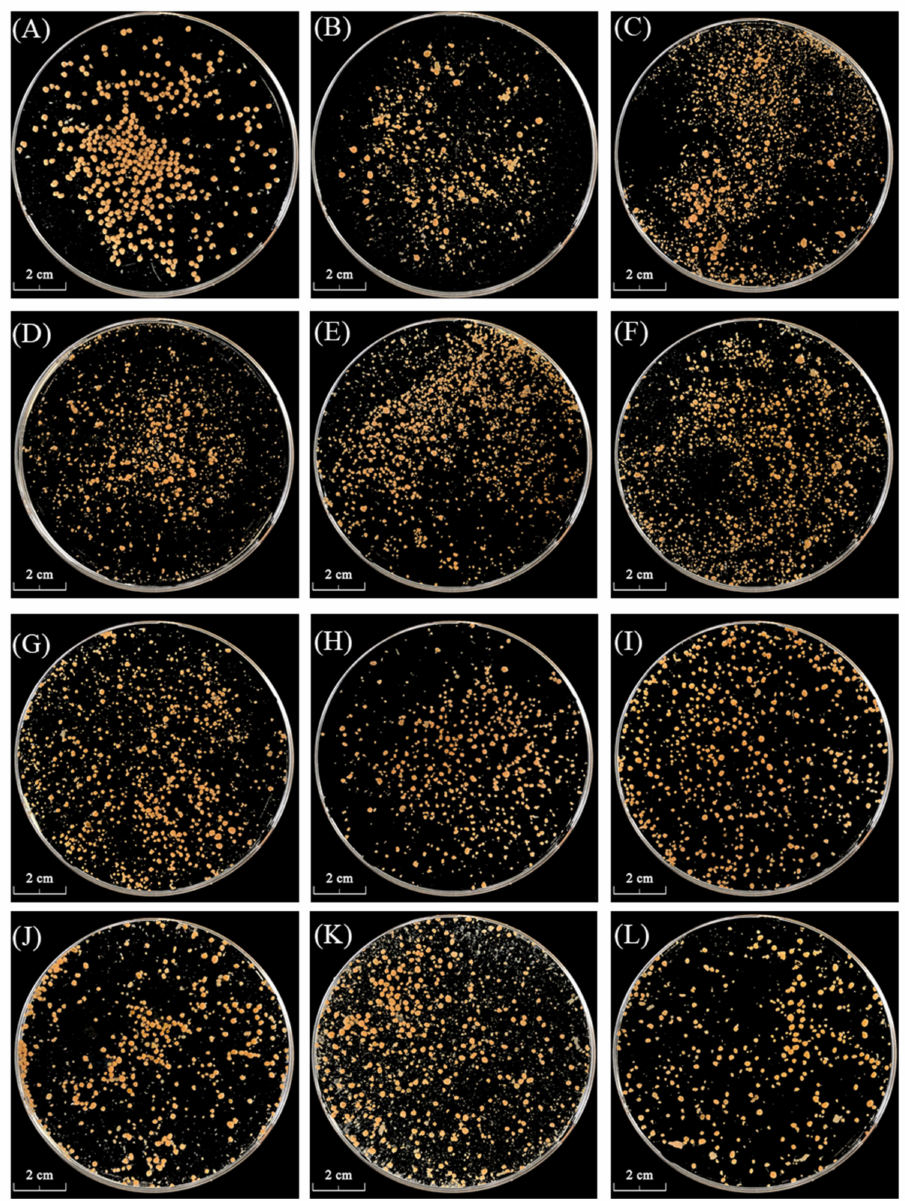
Figure 2. Morphology of nitrifying granules in the GMBR on day 0 ( A ), 37 ( B ), 79 ( C ), 100 ( D ), 130 ( E ), 150 ( F ), 180 ( G ), 210 ( H ), 240 ( I ), 260 ( J ), 280 ( K ) and 305 ( L